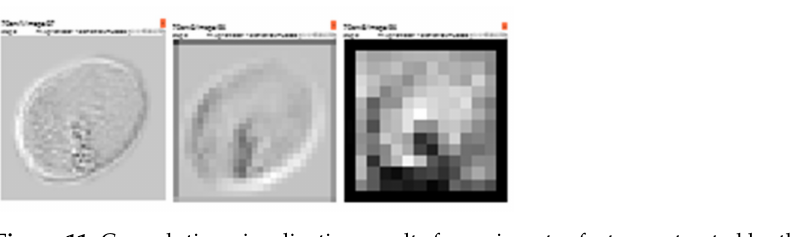
Figure 11. Convolution visualization results for an insect-n feature extracted by the new network-dr model (Convolutional Layers 1–3).